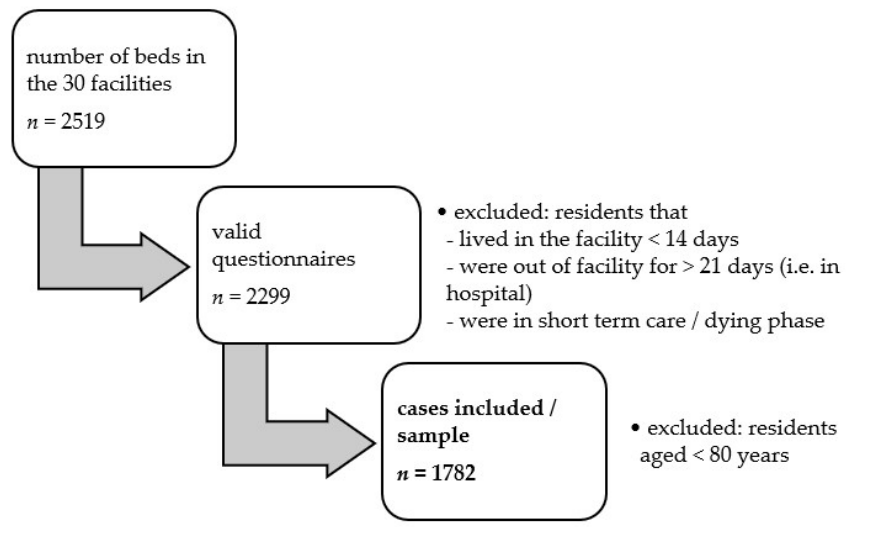
Figure 1. Sample Figure 1. Sample extraction.